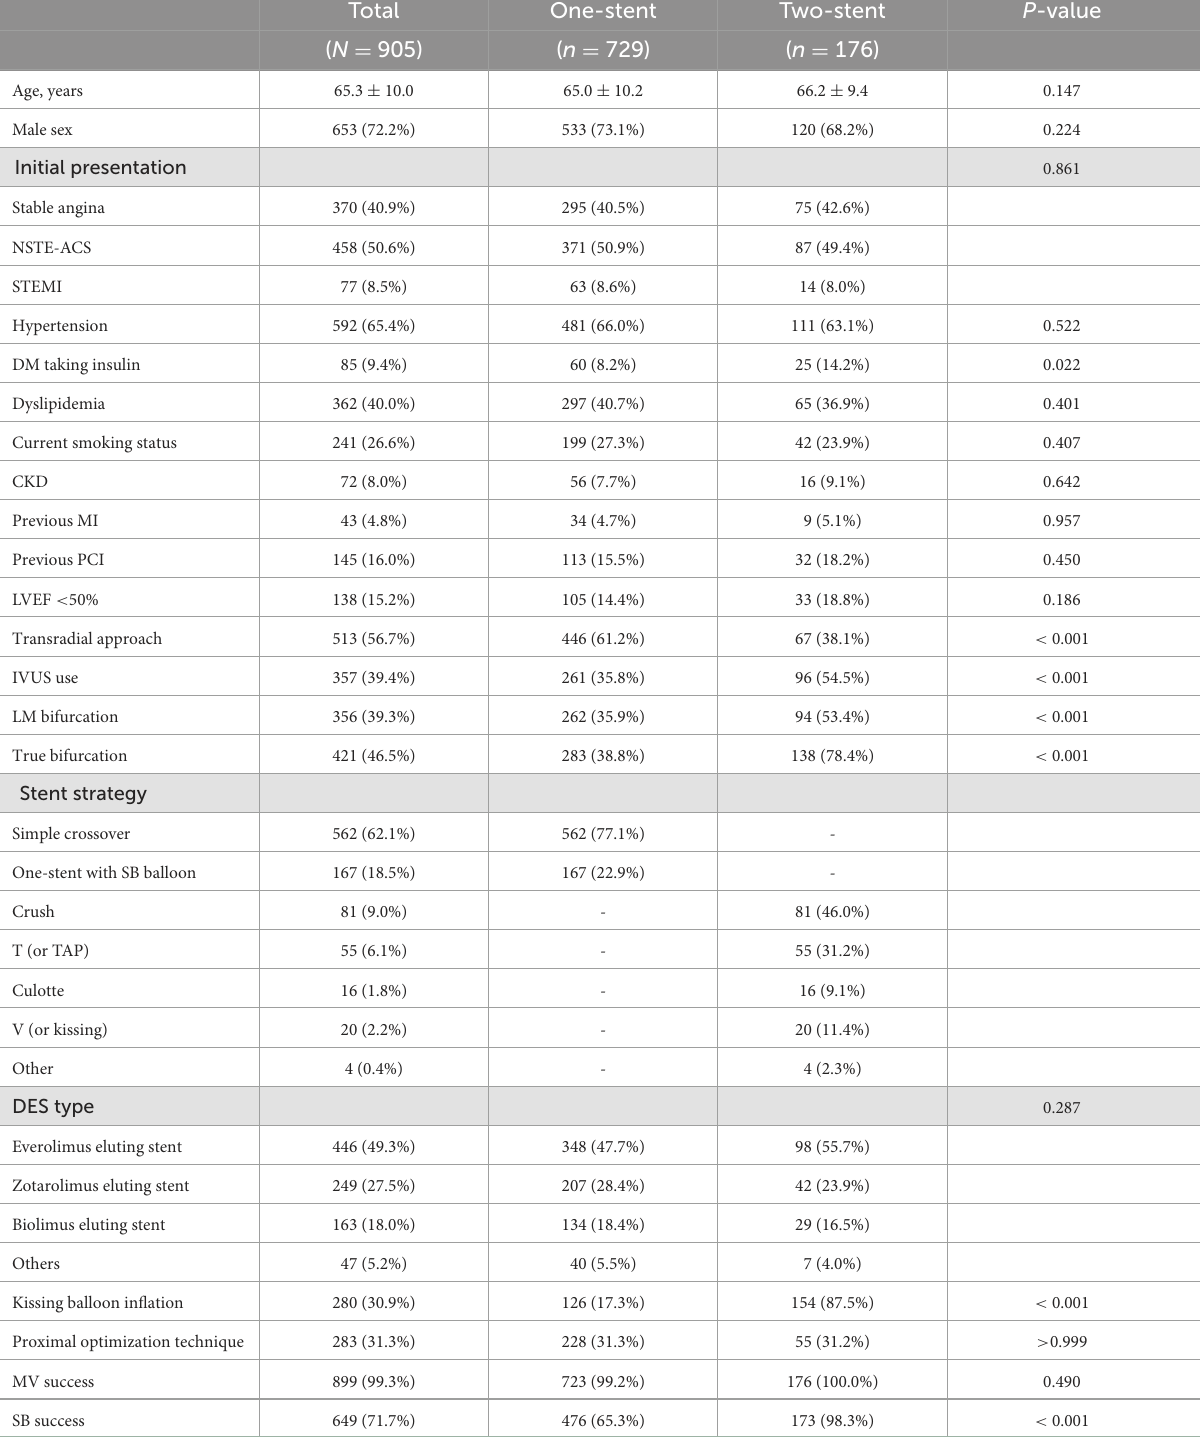
TABLE 1 Patients’ baseline clinical and procedural